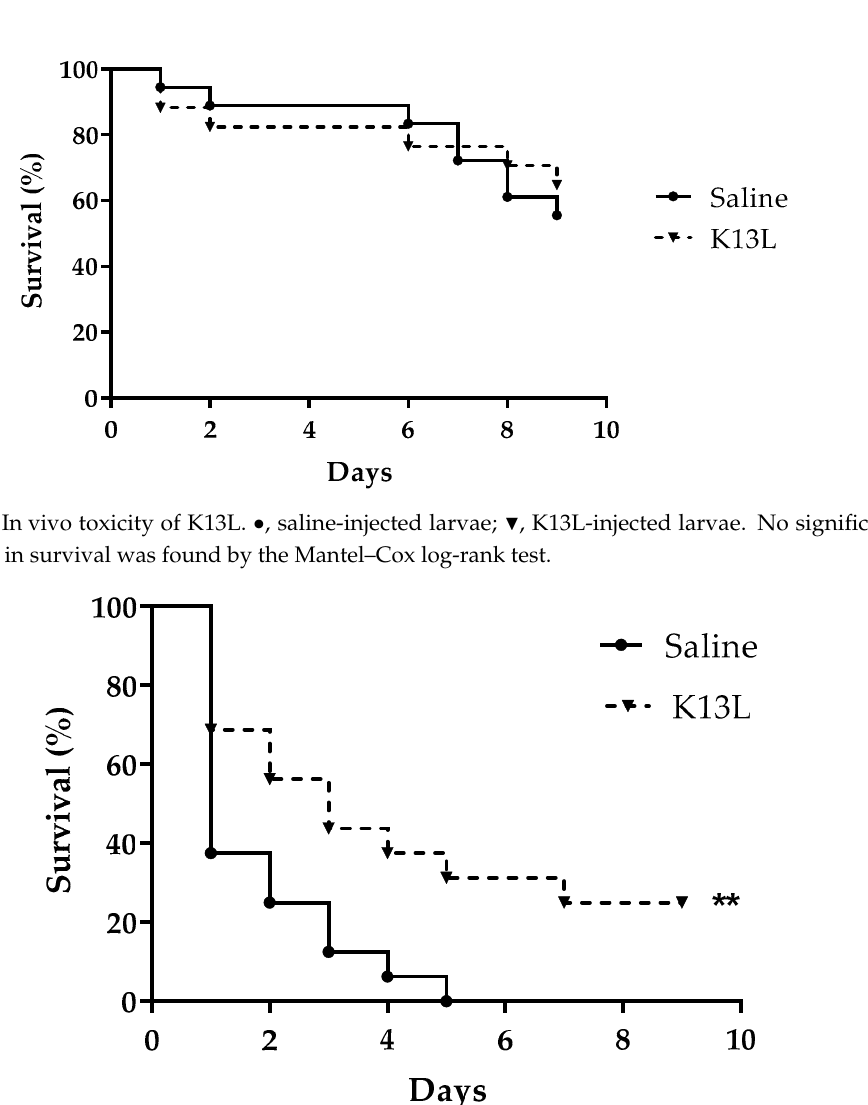
Figure 4. In vivo therapeutic activity of K13L. ● , C. albicans -infected, saline-injected larvae; ▼ , C. albicans -infected, K13L-treated larvae. ** significant difference in survival in comparison to the infected, saline-treated group ( p = 0.0098), as assessed by the Mantel–Cox log-rank test.